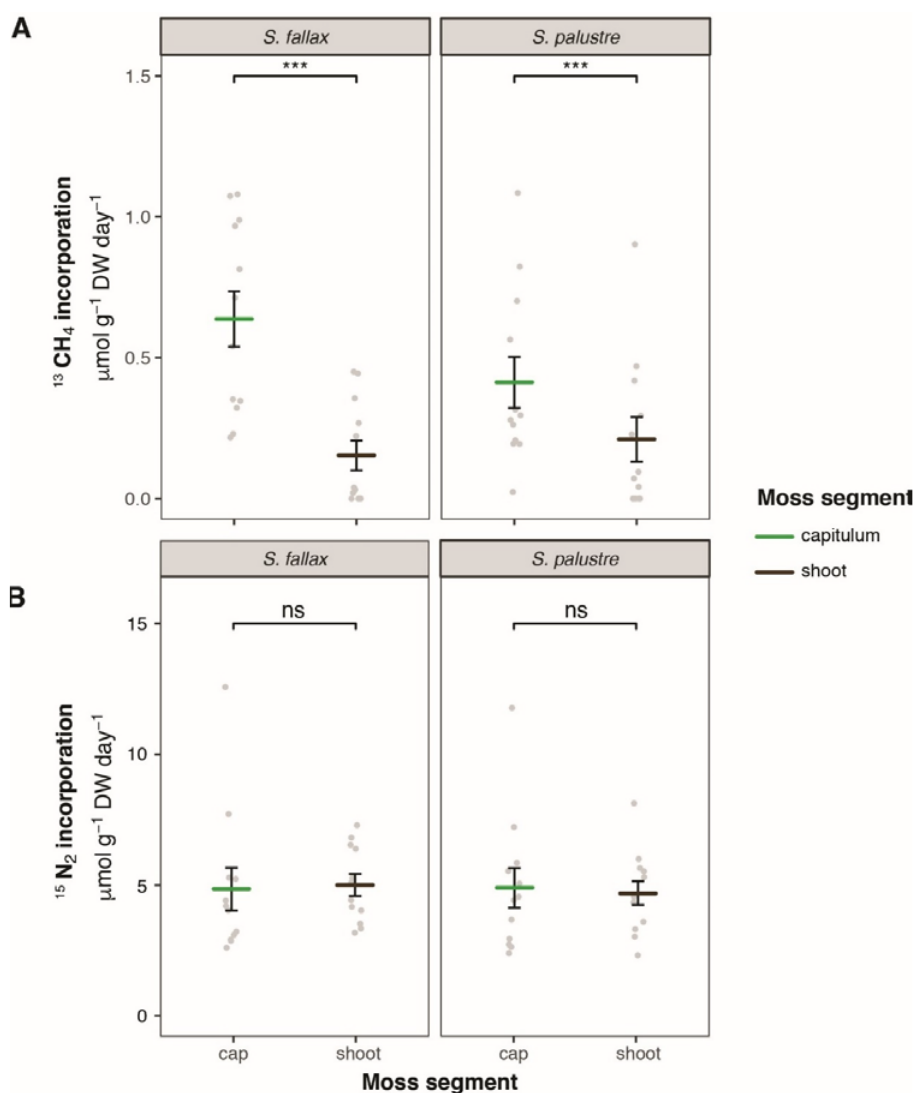
Figure 1. A: Methane oxidation activity ( 13 C-CH 4 incorporation rate); and B: Nitrogen fixation ( 15 N-N 2 incorporation rate) for both Sphagnum fallax and S. palustre segments capitulum (green) and stem (brown). Significant differences are indicated as follows *** p<0.001; ** p<0.01; * P<0.05; ns = not